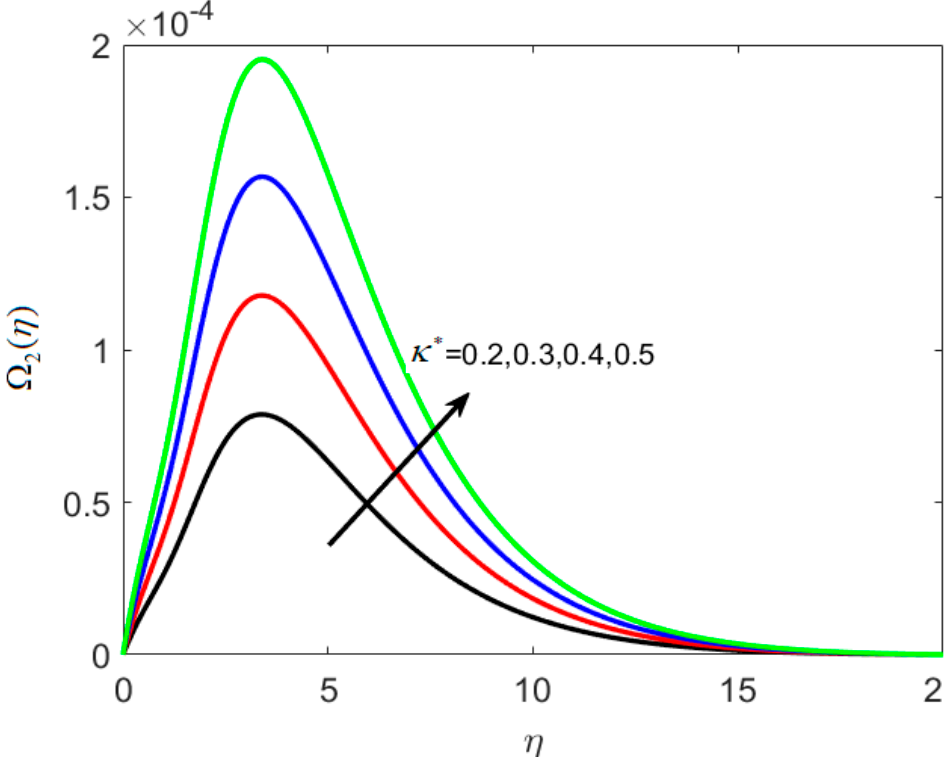
κ ∗ κ ∗ by taking by taking